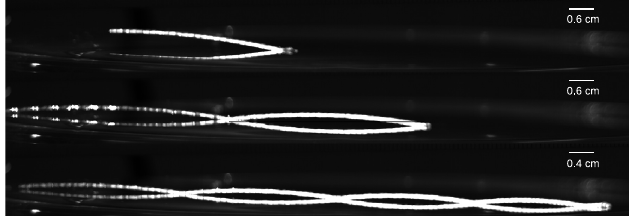
Fig. 6. Trajectory of water drops arriving on a fl at water surface. The drop coalesces (top), bounces two (middle) or four times (bottom). Pictures were obtained by superposition of successive frames. The drop comes from the left and its re fl ection is seen in the water surface.